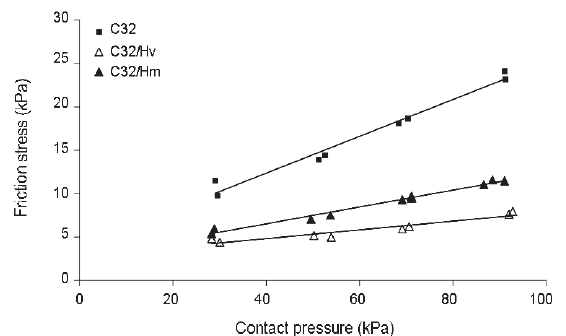
Fig. 10. Evolution of friction stress as a function of contact pressure for C32 with release agent